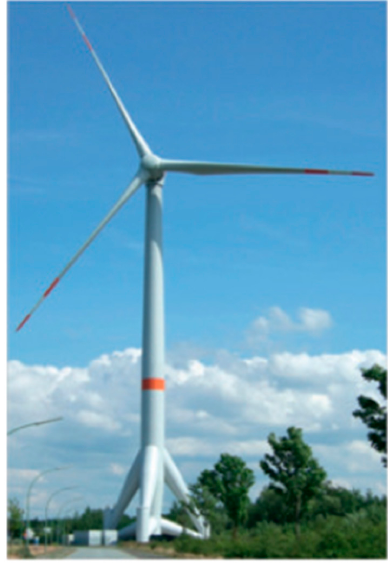
Figure 7. The Areva-M5000. Table 3. Technical parameters of the wind turbine